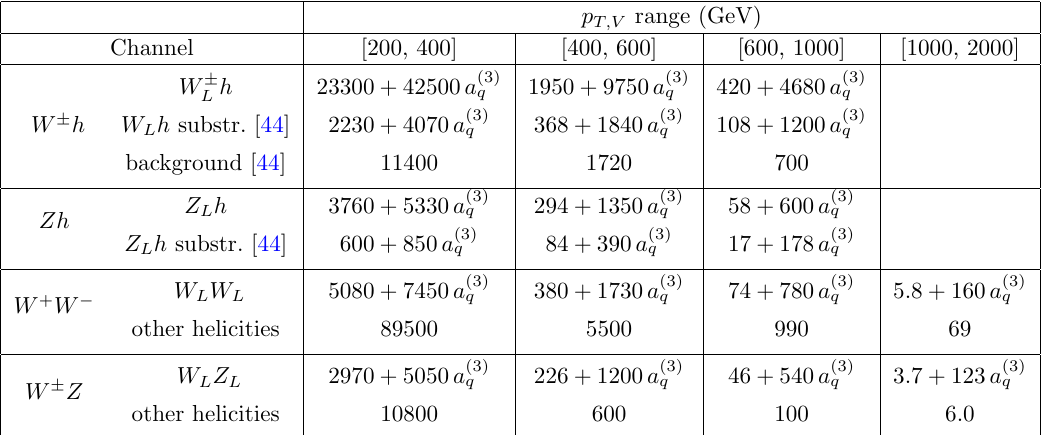
Table 4 . Expected events at the 14 TeV LHC with integrated luminosity 3 ab diboson channels. The rates take into account the branching fractions h ! b (cid:22) b , W ! ‘(cid:23) and Z ! ‘ (cid:22) ‘ with l = (cid:22); e . The number of events in W (cid:6) h and Zh is negligible in the last bin. The value of a (3) q is expressed in TeV (cid:0) 2